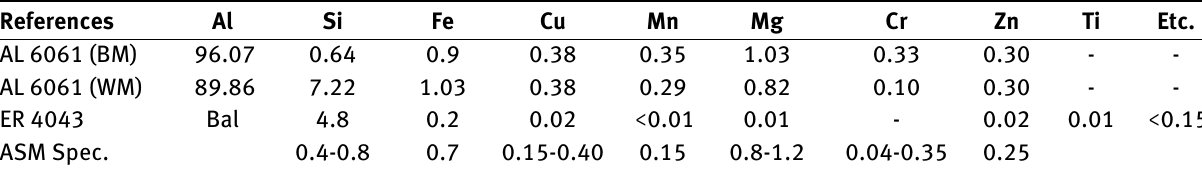
Table 1: The chemical Composition of AL6061 and Wire Filler ER4043 (wt%).